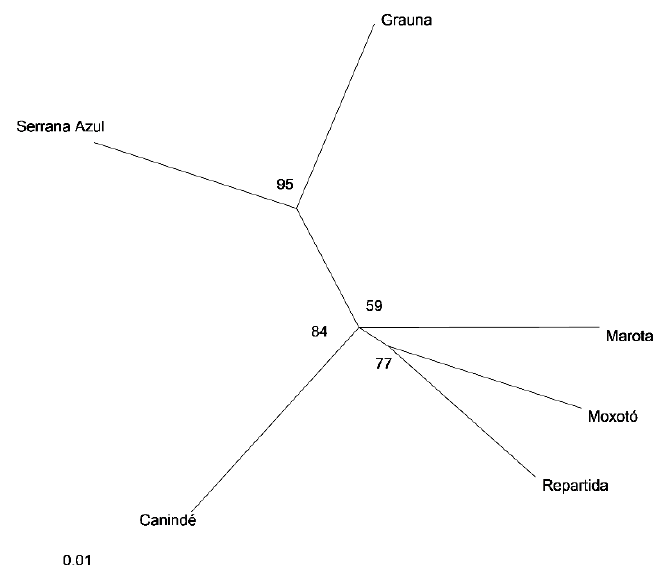
Figure 1. UPGMA dendrogram of Brazilian breeds, based on D A distance [14].